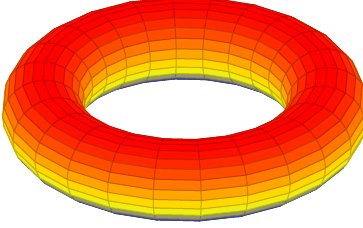
Figure 2. Lattice in form of a torus.